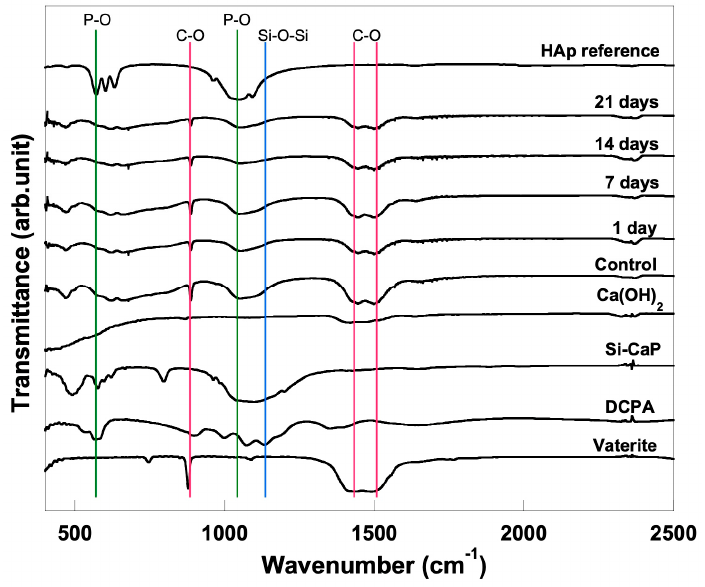
Figure 4. FTIR spectra of CO 3 Ap − Si − CaP − Ca(OH) 2 set cement before and after soaking into SBF for 1, 7, 14, and 21 day(s).